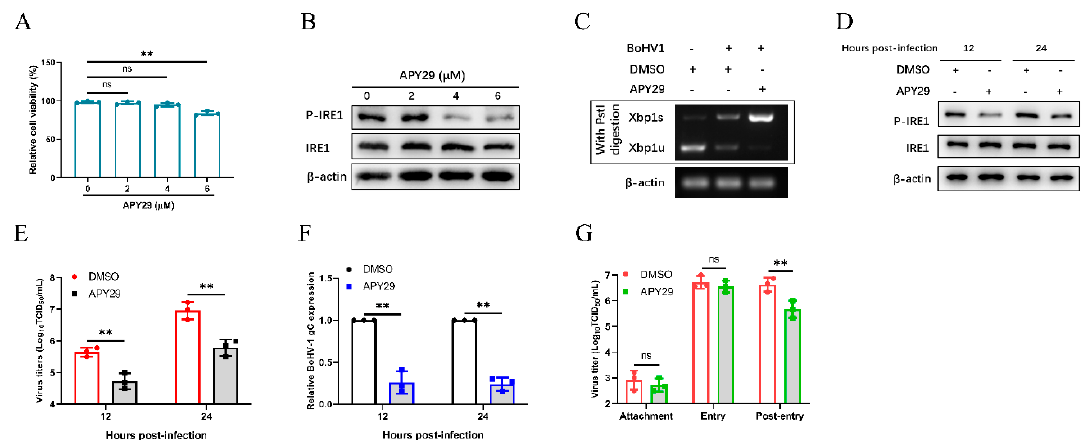
Figure 7. Inhibition of IRE1 kinase activity and promotion of RNase activity decrease BoHV-1 replication. ( A ) The cytotoxicity of APY29 was measured using a CCK-8 assay. ( B ) MDBK cells were treated with different concentrations of APY29, and then challenged with BoHV-1. Immunoblot analysis of total IRE1 and phosphorylated IRE1 in MDBK cells at 24 hpi. ( C ) MDBK cells were treated with APY29 (4 μ M) or DMSO, and followed by infection with BoHV-1. Cells were harvested at 24 hpi and subjected to XBP1 splicing assay. ( D – F ) MDBK cells treated with APY29 (4 μ M) or DMSO were challenged with BoHV-1 (0.1 MOI). Cells were harvested at 12 and 24 hpi. ( D ) Immunoblot analysis of the IRE1 kinase activity at the indicated time points. ( E ) The viral titers of BoHV-1 in MDBK cells at 12 and 24 hpi were determined. ( F ) qPCR analysis of the BoHV-1 gC expression in MDBK cells at the indicated time points. ( G ) Effect of IRE1 kinase activity inhibition and RNase activity enhancement on BoHV-1 replication stages. The mean ± SD of data from three independent experiments are shown; * p < 0.05, ** p < 0.01.